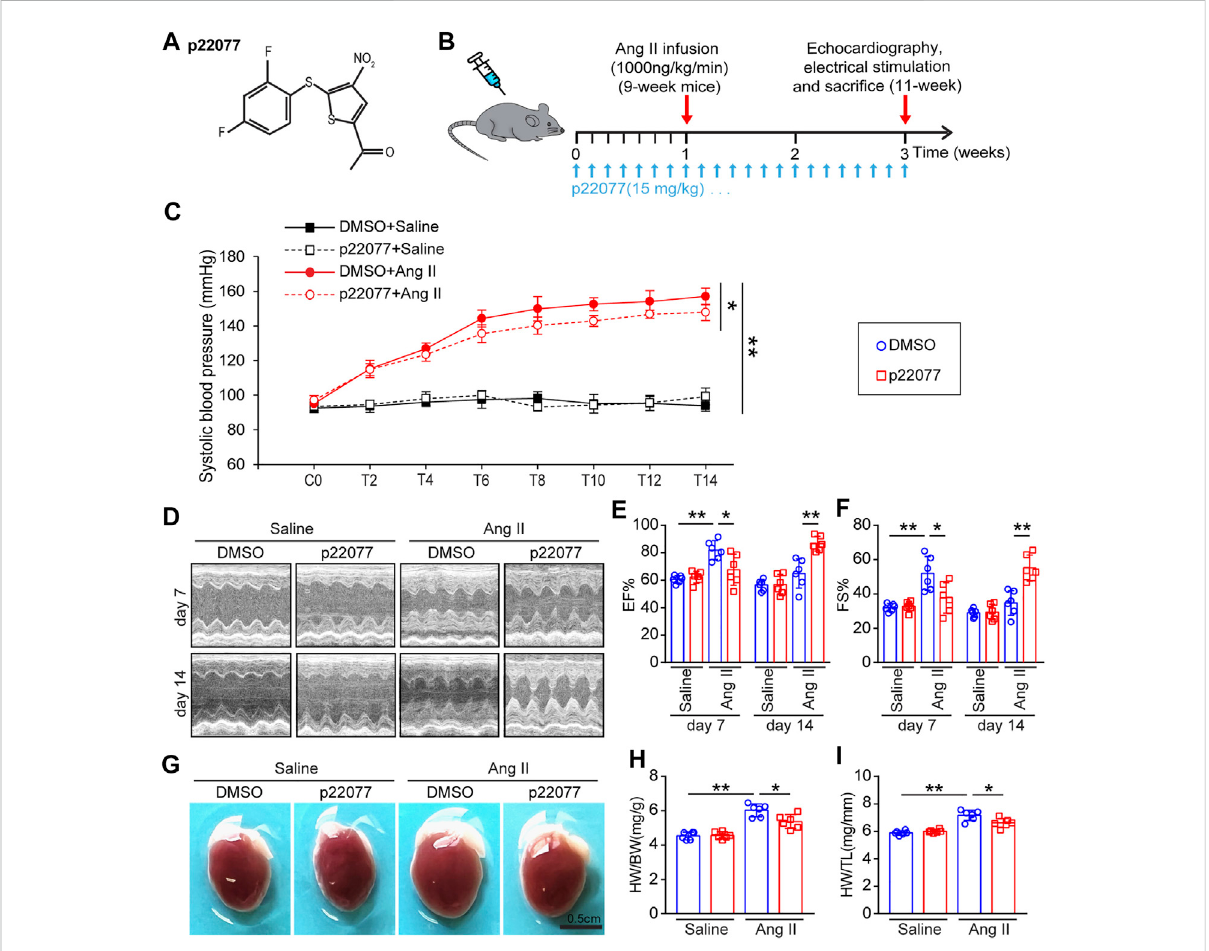
FIGURE 3 Administration of USP7 inhibitor p22077 attenuates Ang II-induced maladaptive cardiac hypertrophy. (A) The basic structure of p22077. (B) Protocol for administration of p22077 in a mouse model of cardiac hypertrophy and remodeling. WT mice were treated with p22077 for 7 days and then infused with Ang II or Saline for additional 14 days. (C) Tail-cuff method measurement of systolic blood pressure (SBP) every 3 days after Ang II infusion ( n =6). (D – F) Representative M-mode echocardiography ofLVchamberatday7andday14.MeasurementofEF%and FS%( n